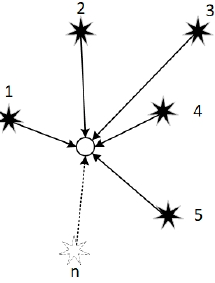
Figure 2. Multi-edge positioning method diagram.